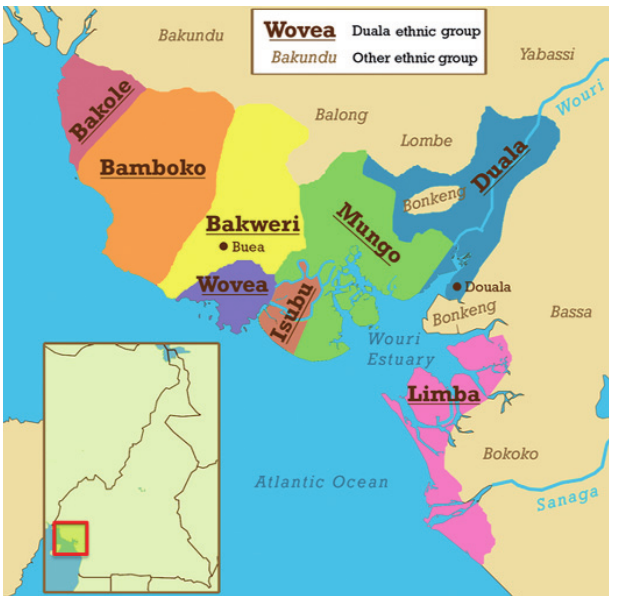
Figure 8. Visit to the Chiefdom of Bonadikombo during the first fieldwork mission.